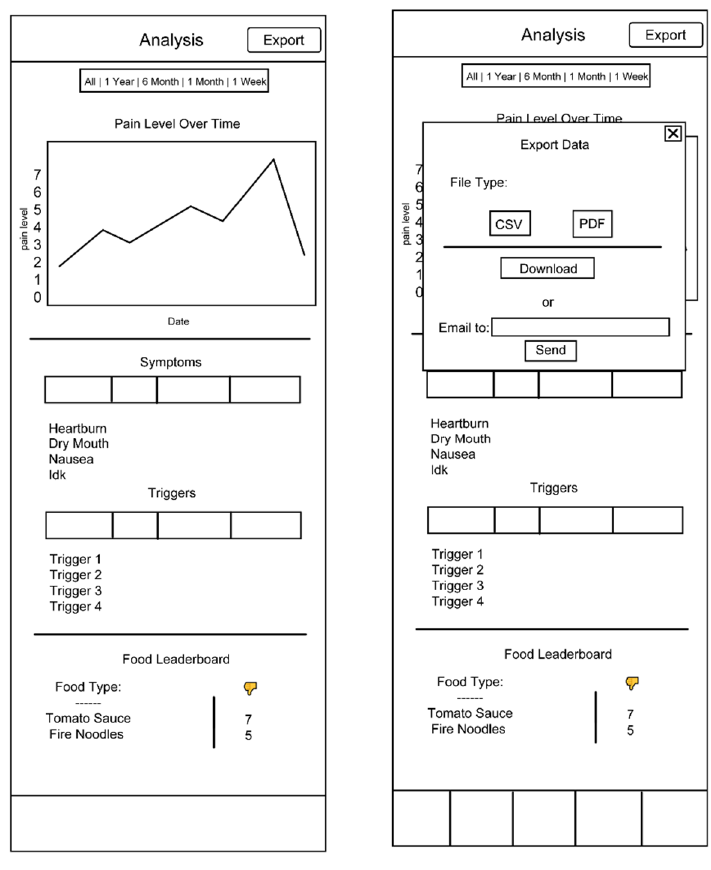
Figure 2. Low-fidelity prototype.